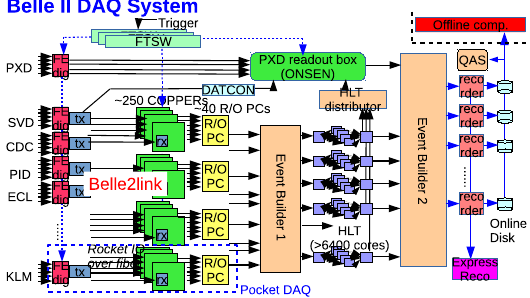
Figure 2. The Belle II Data Acquisition System. The data from detectors are transferred to the com- mon readout cards (COPPER) via the unified optical link (Belle2link). Event building is peformed in multiple steps by the combination of the readout PCs and the event builder switch and the event data are fed into multiple HLT units. The data from PXD are merged with the HLT output and recorded in storage